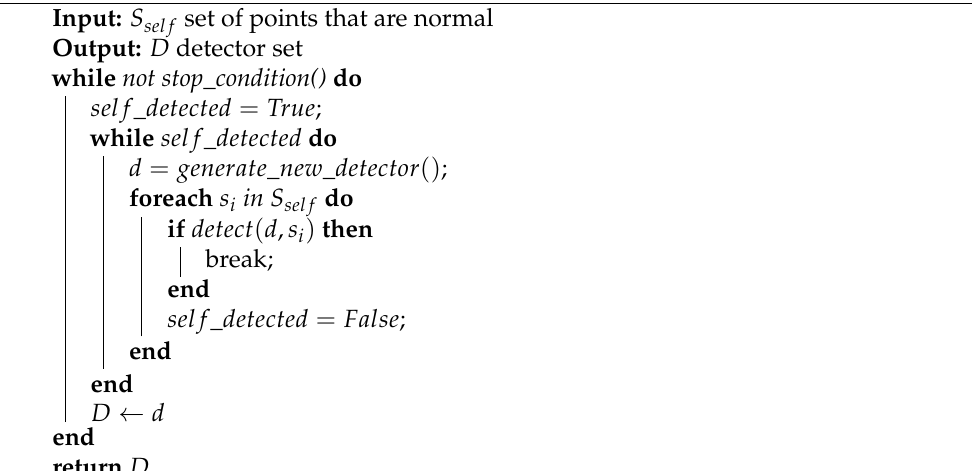
Algorithm 1: General Negative Selection Algorithm (NSA) Detector Set Genera-